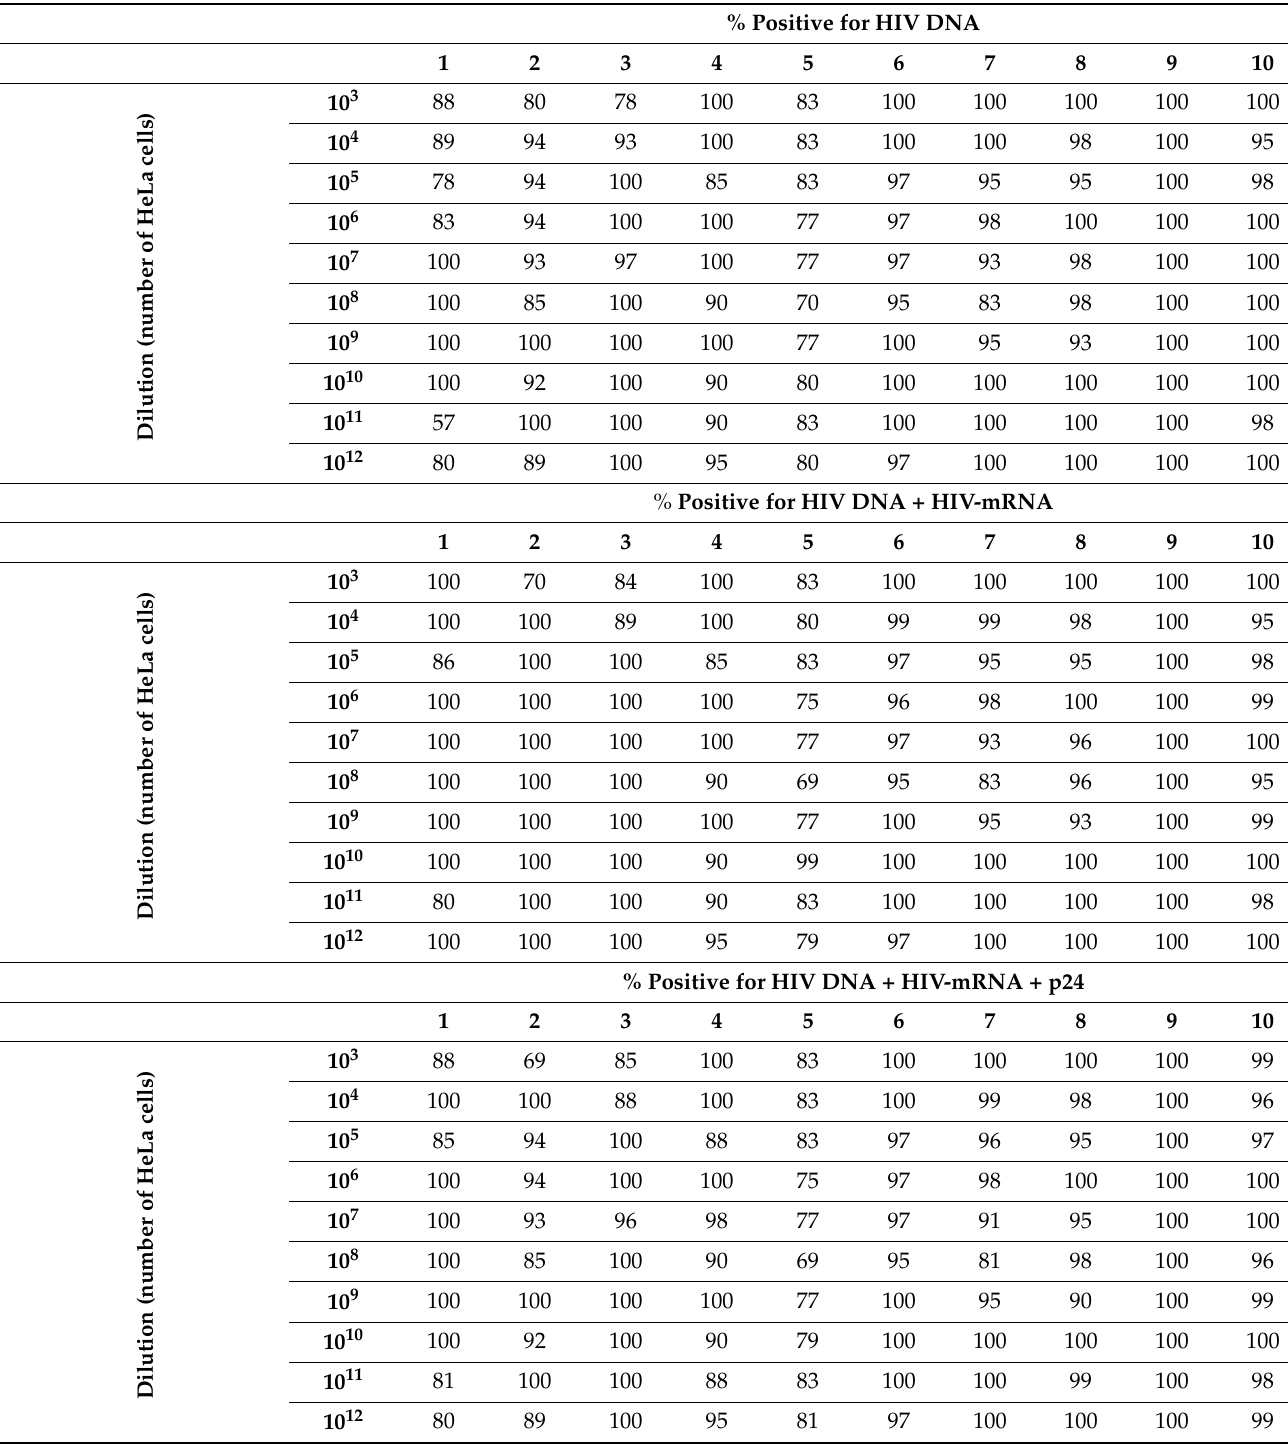
Table 4. Detection of HIV DNA, HIV-mRNA, and HIV-protein in OM-10 cells. To calculate our image system’s sensitivity to detect viral reservoirs, we diluted cells with one copy of integrated HIV DNA (OM-10). One to ten cells were diluted in 10 3 to 10 12 HeLa cells. Then, staining for HIV DNA (top), HIV-mRNA (middle), or HIV-p24 (bottom) was performed to identify whether we could detect the diluted cells in the HeLa cells. The percentage of detection is indicated for 10 sample preparations for each dilution. Pellets of these cells were cut and analyzed by microscopy to identify the infected cells. These cells were not treated with reactivating agents, such as TNF- α or SAHA. Thus, detection corresponds to the baseline viral